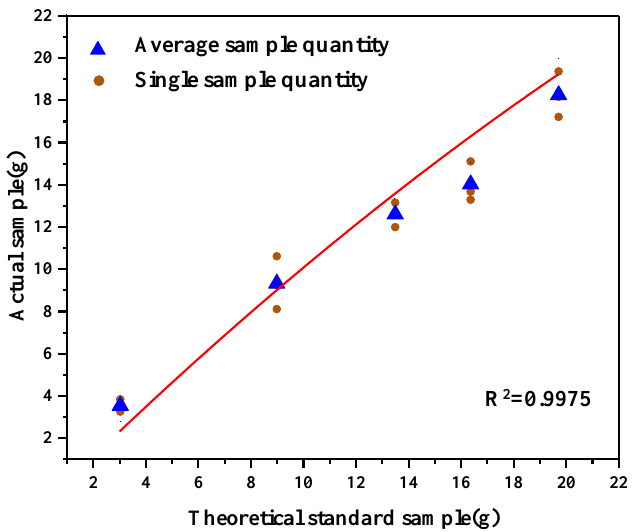
Figure 11. Correlation between theoretical capture and actual capture.